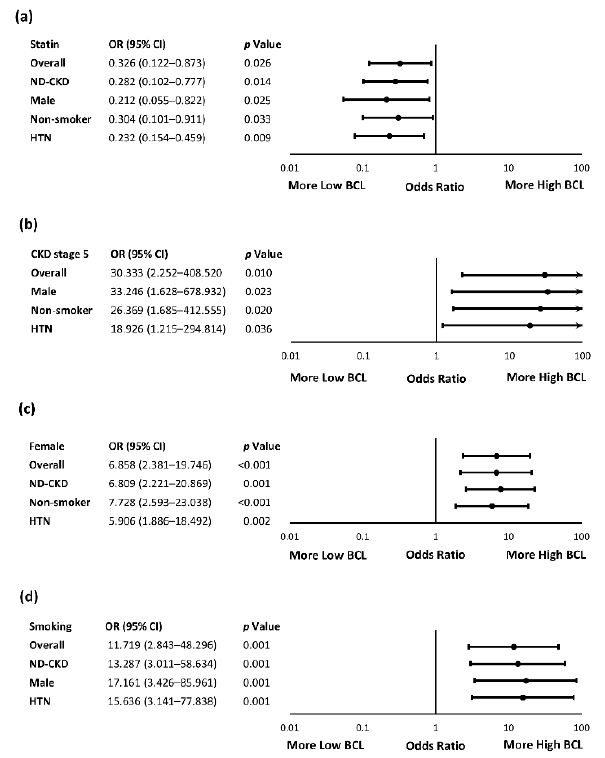
Figure 2. The Effects of BCL Associated Factors in Specific Subgroups. ( a ) Statin effects in subgroups; ( b ) CKD Stage 5D effects in subgroups; ( c ) female sex effects in subgroups; ( d ) smoking effects in subgroups. The numbers of specific subgroups were: ND-CKD ( n = 179), male sex ( n = 129), non- smokers ( n = 174), and HTN ( n = 171), respectively. HTN, hypertension; ND-CKD, non-dialysis CKD.